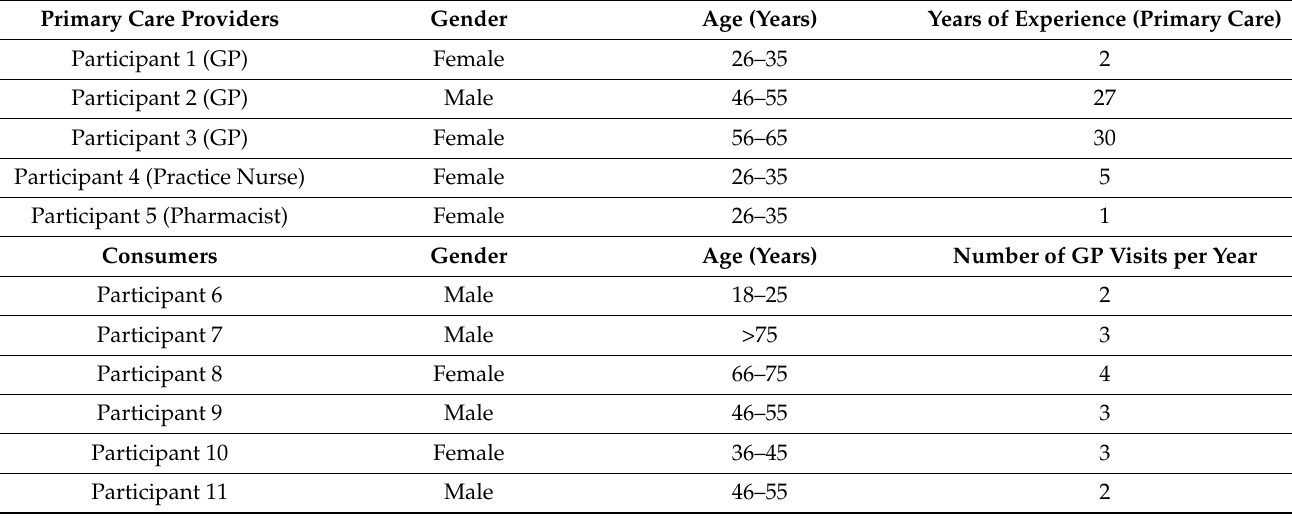
Table 1. Demographics of primary care providers and